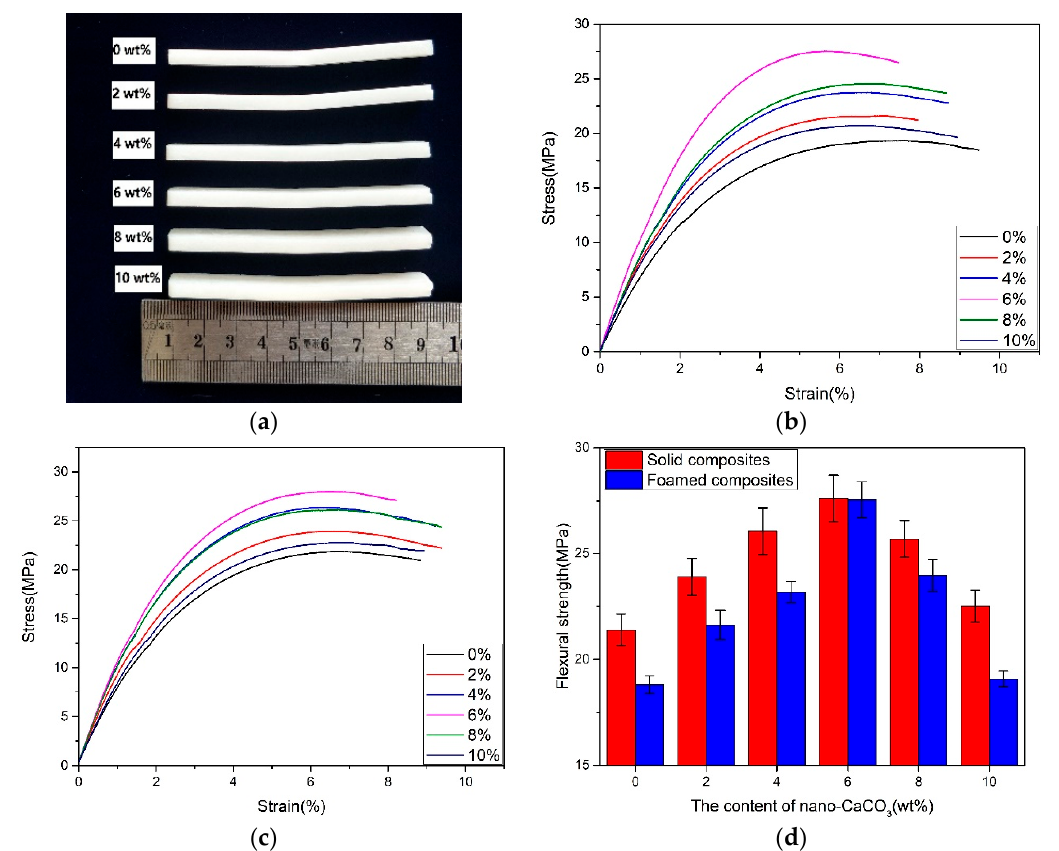
Figure 7. The results of the flexural tests are as follows: ( a ) the foamed samples after flexural testing; ( b ) the flexural strain–stress curves of the foamed composites; ( c ) the flexural strain–stress curves of the solid composites; ( d ) the flexural strength.